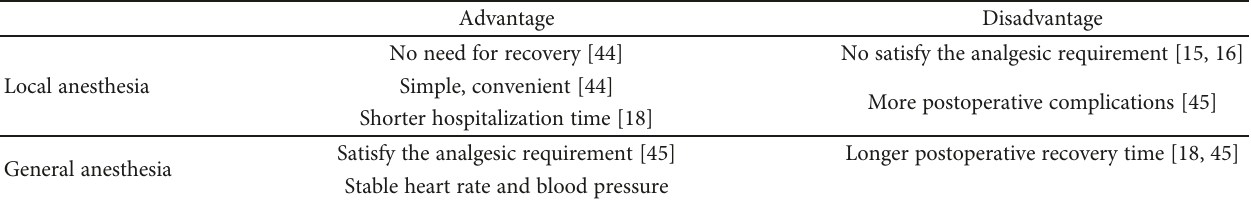
Table 1: Comparison between local anesthesia and general anesthesia.